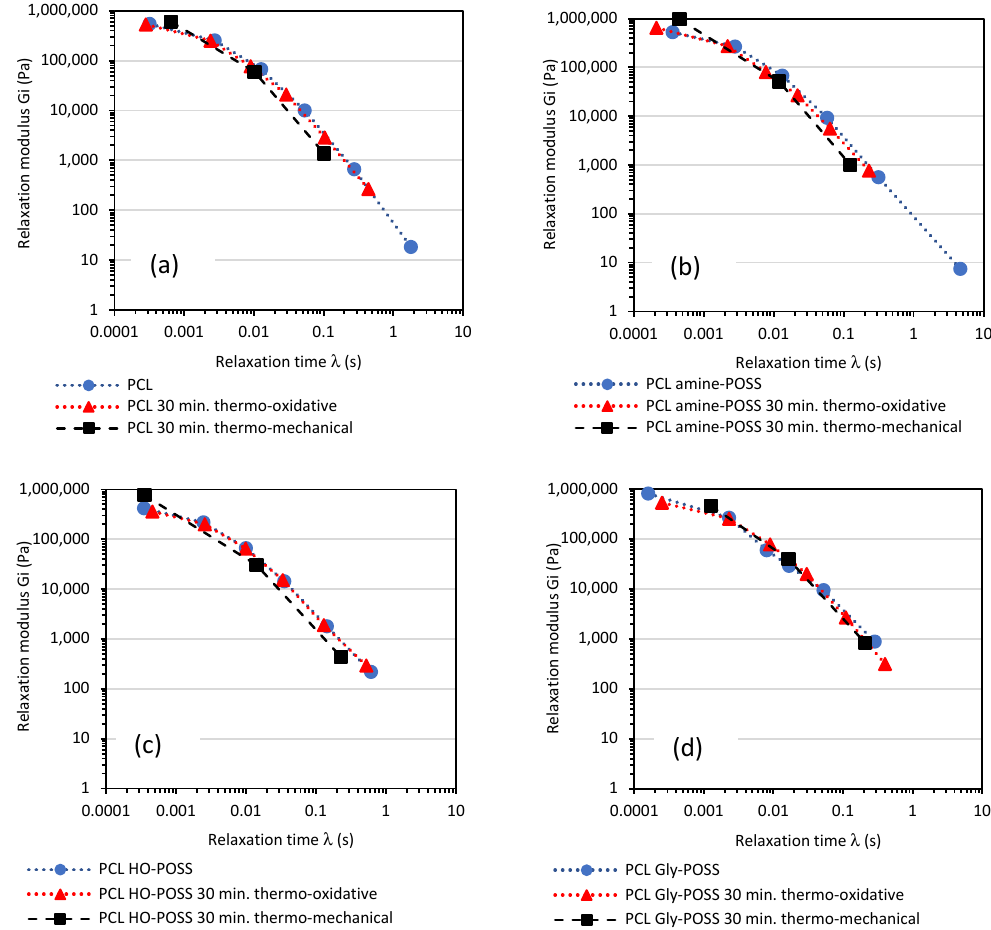
Figure 11. Discrete relaxation Maxwell’s spectra for PCL ( a ) and PCL modified by POSS ( b – d ), samples before and after thermo-oxidative ageing (100 ◦ C, oxygen) or thermo-mechanical ageing (100 ◦ C, oxygen, mechanical stress equivalent of 50 s − 1 shear rate) over 30 min.